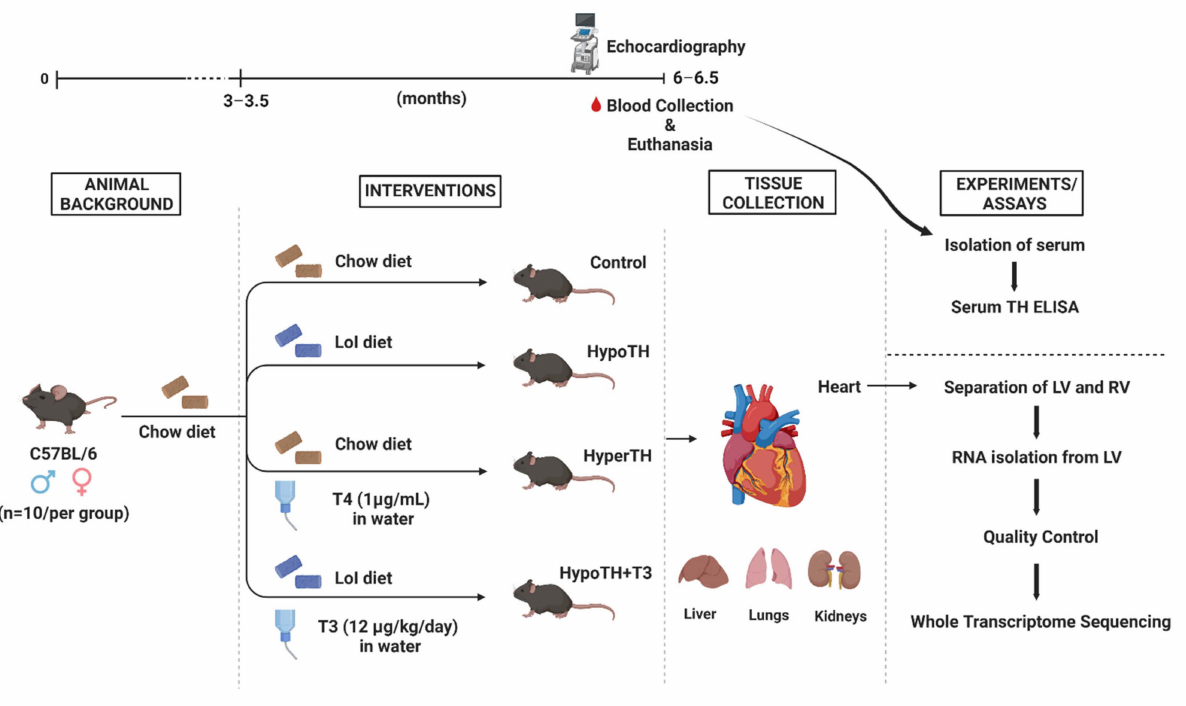
Figure 11. Experimental protocol design leading to WTS: Complete protocol and timeline is presented for the animal experiments in this study (the image was created with